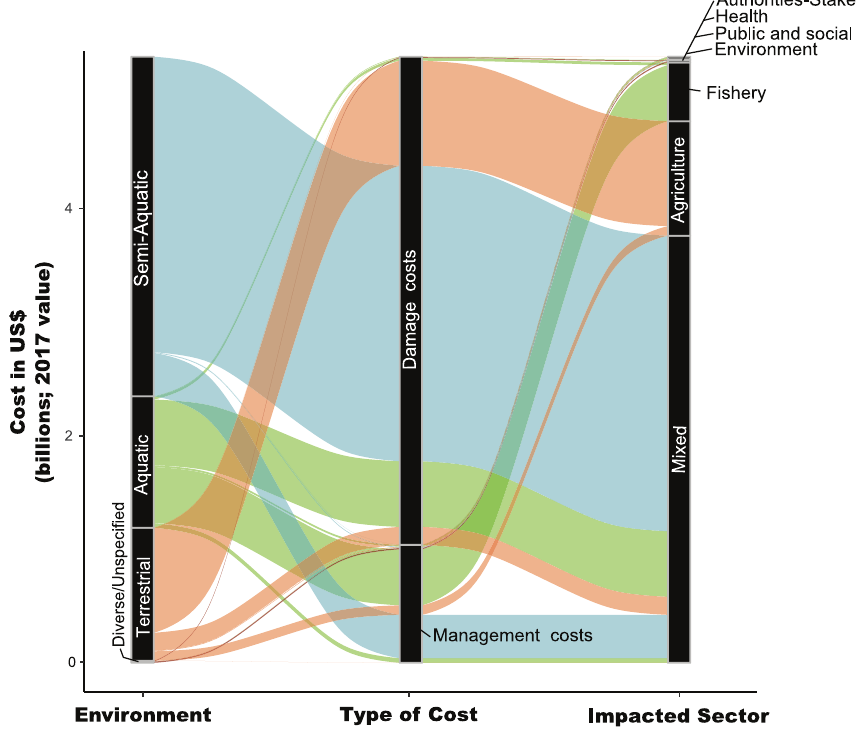
Figure 2. Alluvial plot illustrating flows of invasion costs from different environments to socioeconomic sectors according to types of costs associated with invasive species in Mexico. Costs are reported in US$, billion (i.e., 10 9